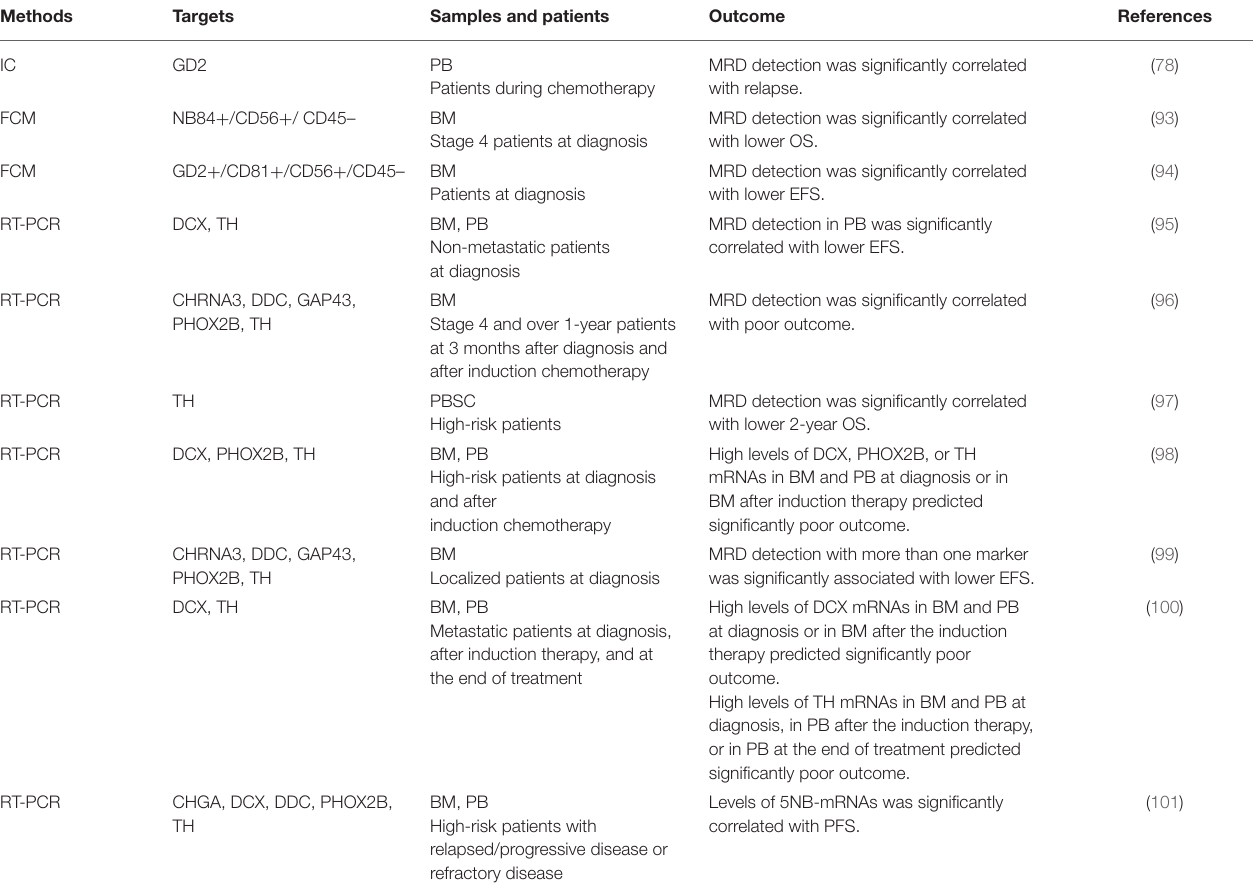
TABLE 4 | Prognostic significance of neuroblastoma MRD detection methods.